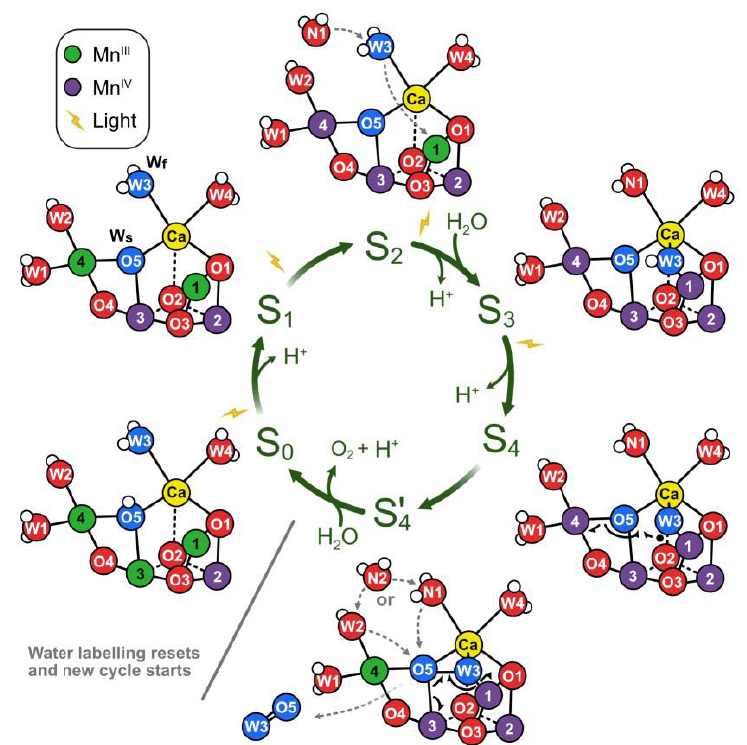
Figure 6. Molecular details of the Kok cycle (cf. Figure 3). Red and blue circles, oxygen; white, hydrogen; green and violet, manganese; yellow, calcium. In the transition from state S 0 to state S 1 , the proton on oxygen O5 is released, and Mn3 is oxidized. In dark-adapted PSII, the reaction cycle starts with the S 1 state with two MnIII and two MnIV ions and in which all bridges are deprotonated. During the S 1 /S 2 transition, Mn4 is oxidized. State S 2 involves several conformations (not shown). In the transition from S 2 to S 3 , water W3 is inserted into the binding site between Ca 2 + and Mn1, concomitant with Mn1 oxidation and the binding of a new water molecule (N1) to the W3 site (dashed grey arrows). Only after rearrangements within S 3 (not shown) can the Mn4CaO6 cluster be oxidized to S 4 . Instead of Mn oxidation, S4 state formation involves the oxidation of the fast substrate water, indicated by a black dot on W3. By rearranging the electrons of the chemical bonds (black half-arrows), the S 4 state rapidly converts into the S 4 (cid:48) state, which contains a complexed peroxide. The further conversion of S 4 (cid:48) into S 0 + O 2 requires the binding of one water molecule and the release of a proton. It is suggested that a prebound water ligand (W2 or W3) fills the empty O5 binding site and that this ligand is concomitantly replaced by a new water molecule (N2; dashed grey arrows). In the S 0 state, the O5 bridge is protonated, in line with the faster exchange of Ws and spectroscopic data. From de Lichtenberg et al. [25], https://creativecommons.org/licenses/by/3.0/, accessed on 27 July 2022. Many other versions of this cycle have been published (see the main